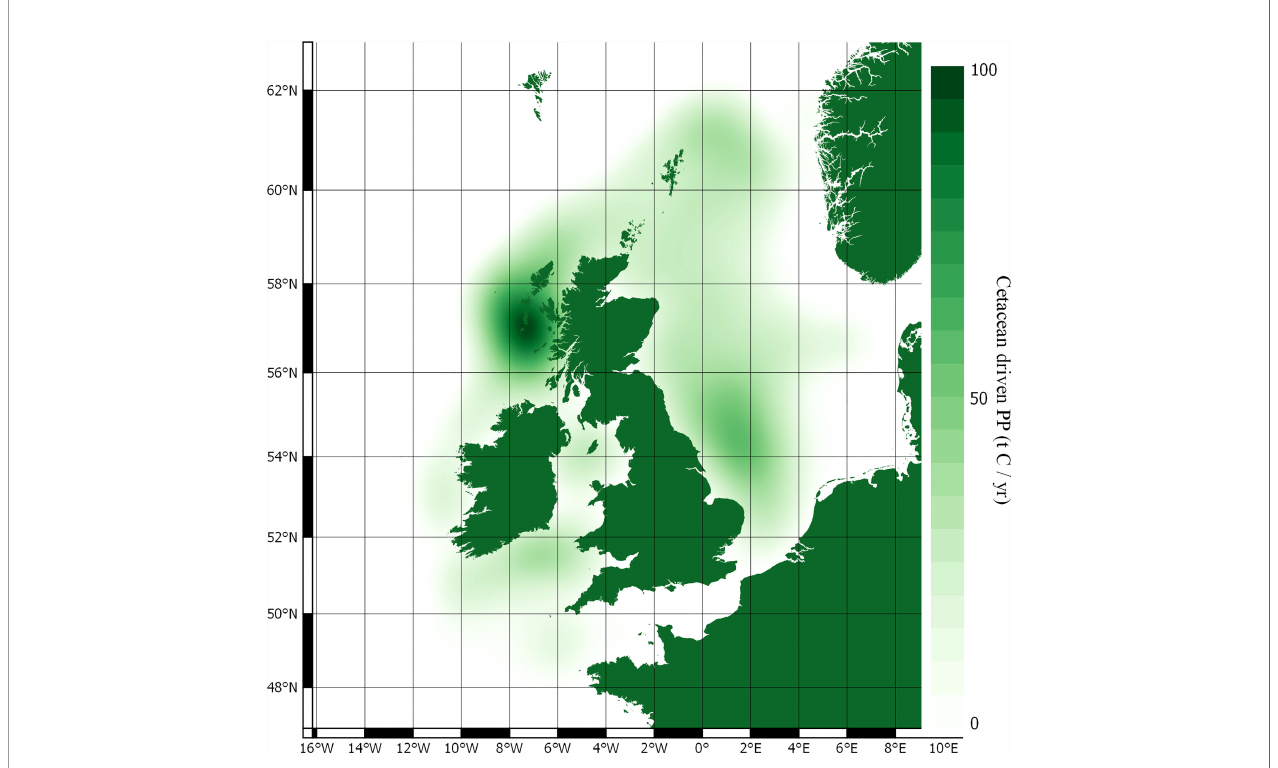
FIGURE 4 | Cetacean driven PP carbon fl uxes.